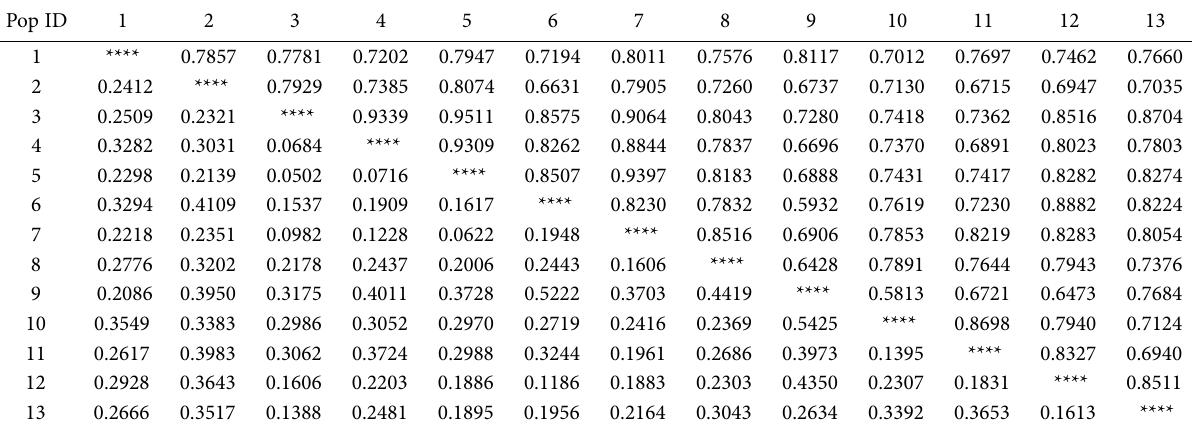
Table 6. Nei , genetic distance and genetic identity (populations numbers are according to Table1). Pop ID